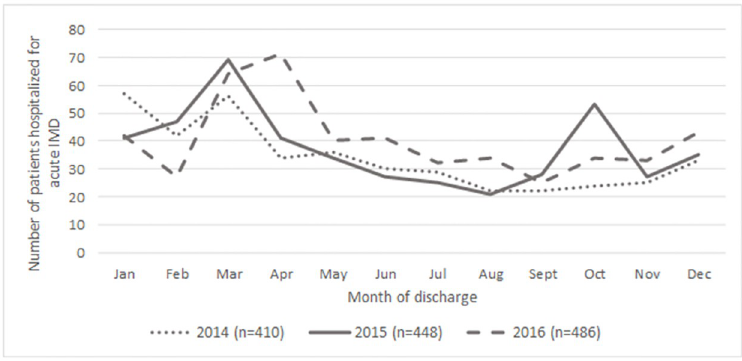
Fig 1. Number of IMD cases identified during the study period